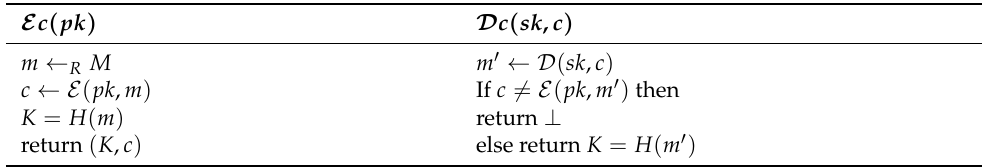
Table 1. Generic construction of a KEM from a DPKE (U